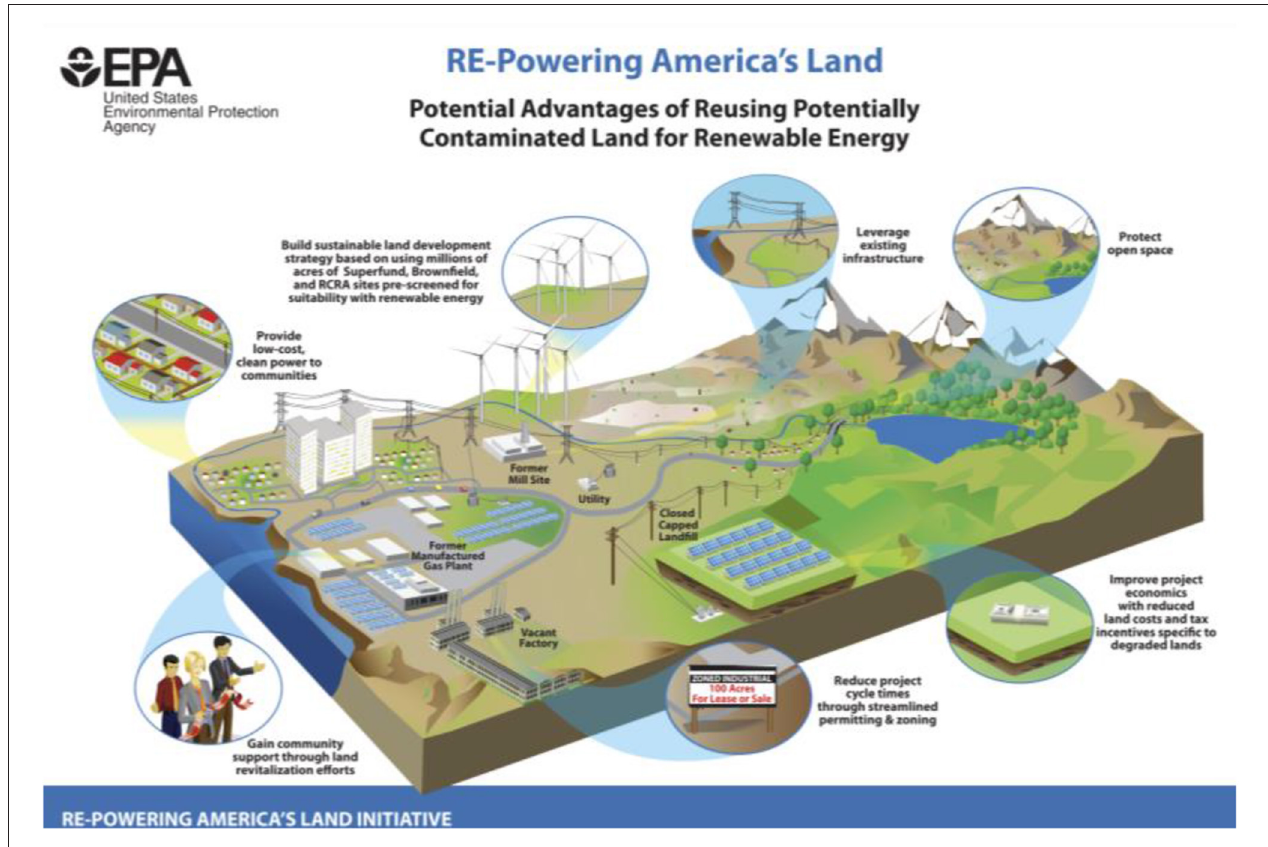
FIGURE 2 | Schematic Re-powering America’s land initiative (EPA,